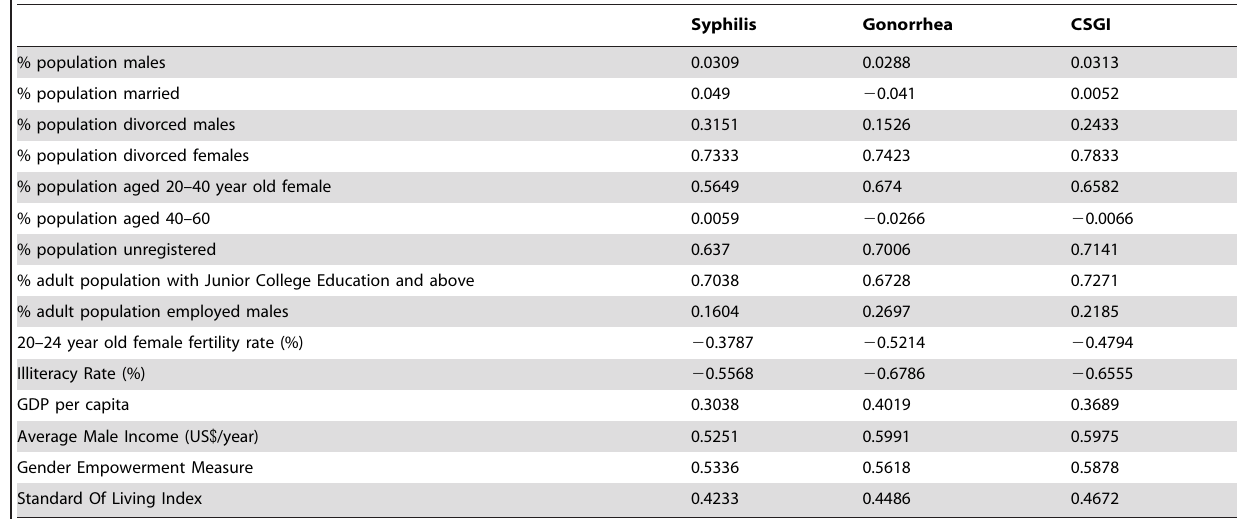
Table 2. Spearman’s Rank Correlation.